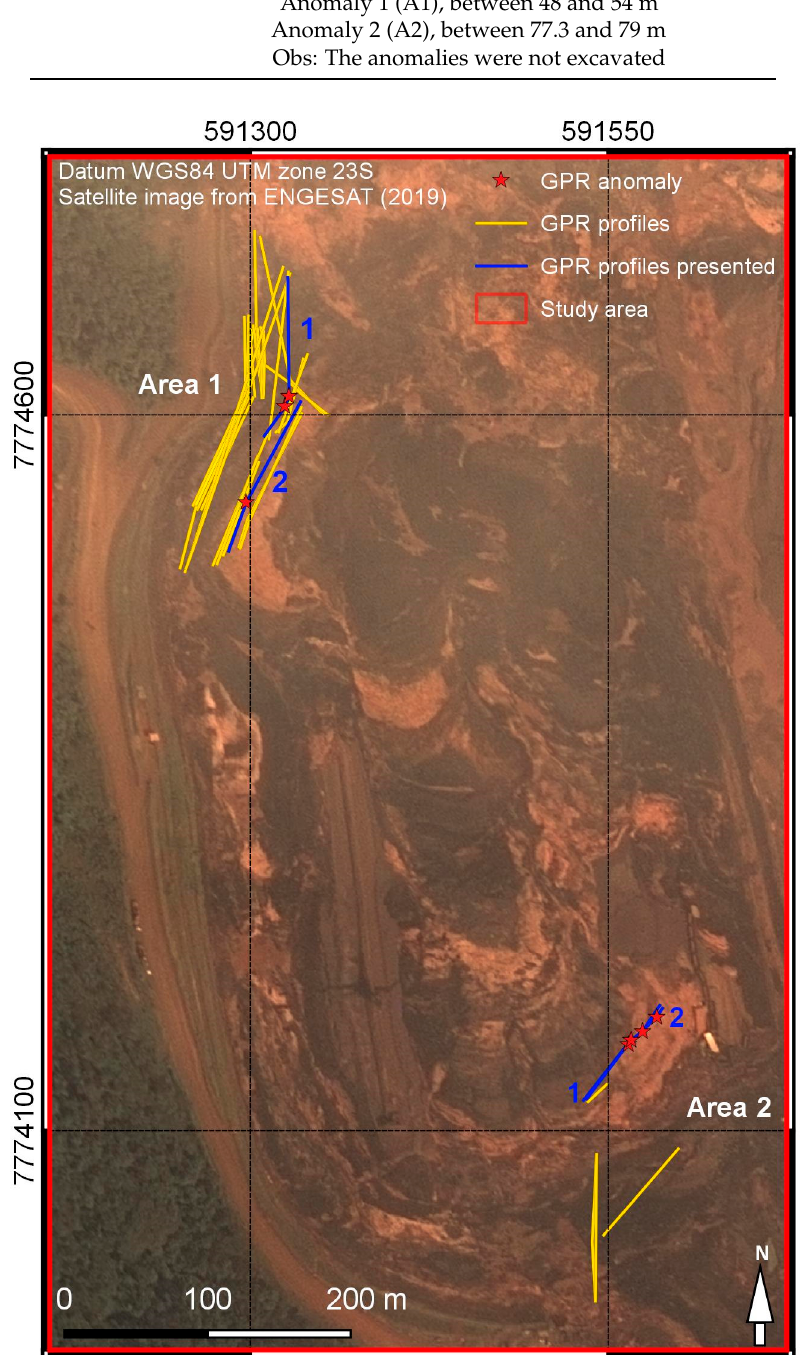
Figure 3. Location of ground-penetrating radar (GPR) profiles in the two study areas in the Brumadinho mine. Area 1, near the Ore Treatment Installation (Instalação de Tratamento de Minério—ITM). Area 2, near the train wagons and a locomotive.